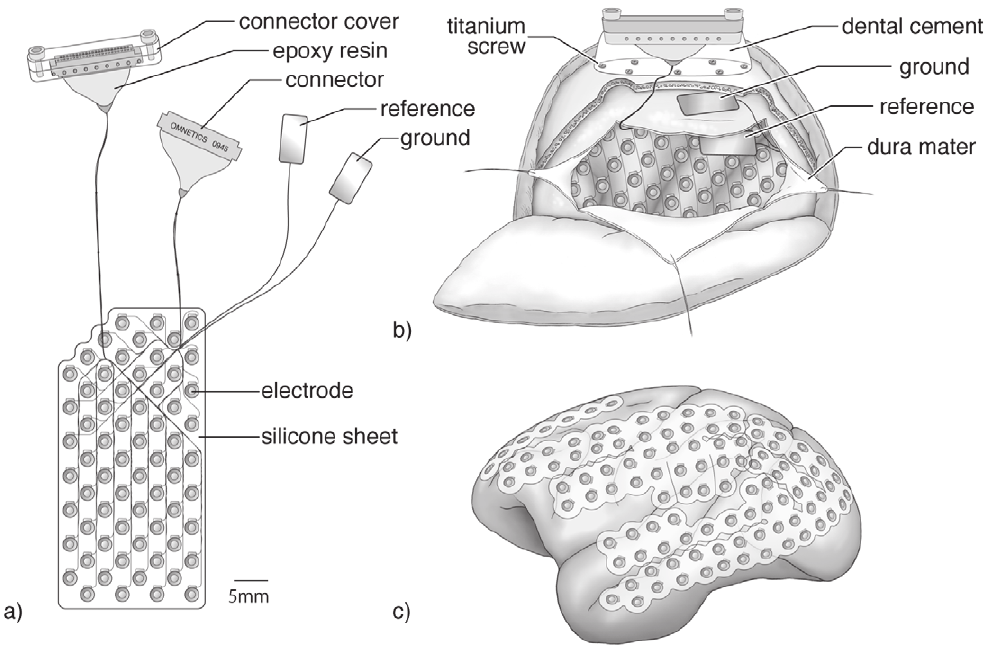
Figure 1. ECoG array, implantation and cortical coverage. a) Sixty-four channel ECoG array with connectors and the reference and ground electrodes. b) Schematic figure showing how and where the ECoG array, reference electrode, ground electrode, and connectors were implanted c) Schematic view showing how the 128-channel ECoG electrode can cover the entire lateral cortical surface.